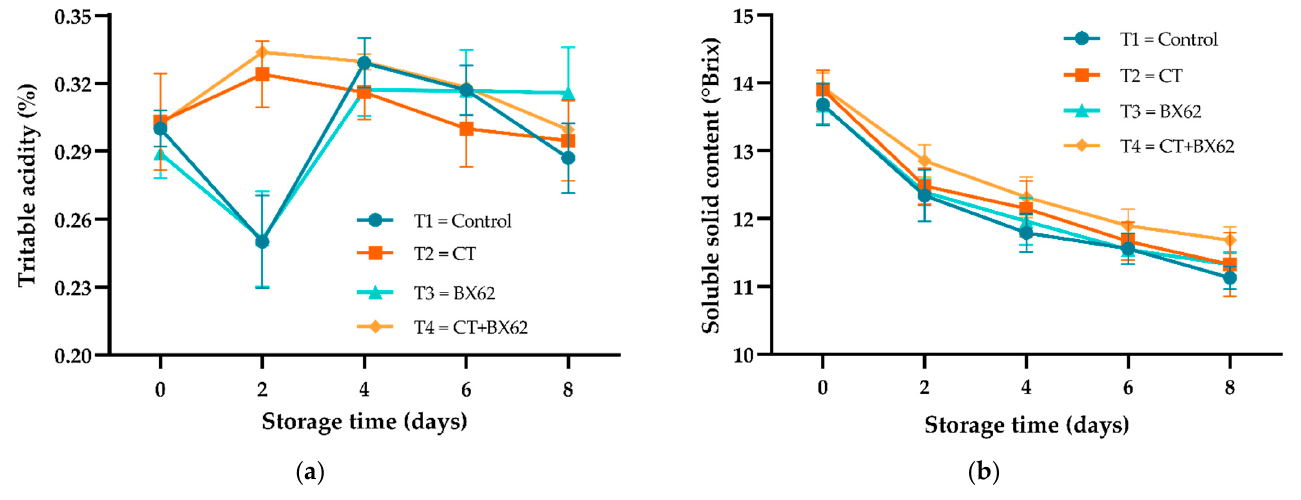
Figure 3. Changes in TA ( a ) and SSC ( b ) for the control apples ( ● ), chitosan-treated apples ( ■ ), L. plantarum BX62-treated apples ( ▲ ), and chitosan in combination with L . plantarum BX62-treated apples ( ◆ ) after being stored at 4 °C for 8 days. Each data point is the mean of three replicate samples.